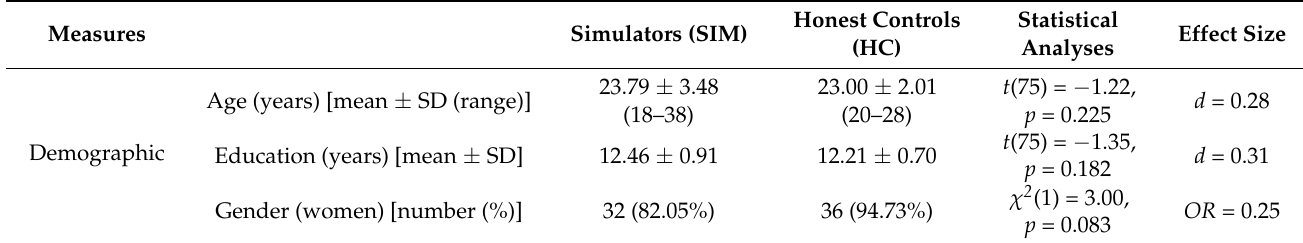
Table 3. Demographic and outcome measures of the MPMT among simulators ( n = 39) and honest controls ( n = 38).